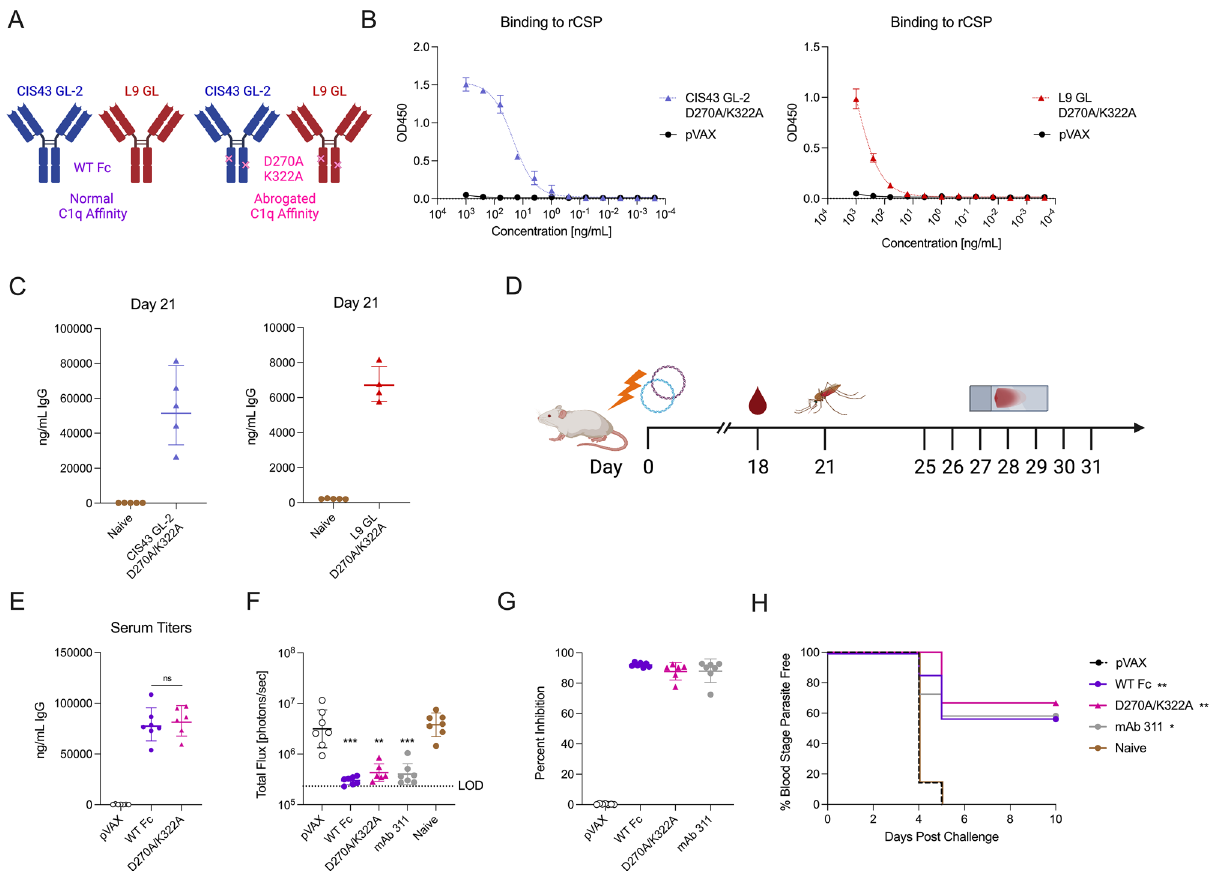
Figure 3. Complement-binding knockout modifications do not impact protection in mosquito bite challenge model. ( A ) Graphical representation of complement modifications of CIS43 GL-2 and L9 GL. ( B ) Binding ELISA of pooled supernatants of CIS43 GL-2 constructs (left) and L9 GL constructs (right) harvested from Expi293F transfection to rCSP (mean ± SD). ( C ) In vivo expression of CIS43 GL-2 D270A/K322A (left) and L9 GL D270A/K322A (right) in BALB/c mice at the peak expression timepoint Day 21. Mice were immunized with 100 µg CIS43 intramuscularly in the tibialis anterior with CD4+/CD8+ T cell depletion (n = 5 mice/group; geometric mean ± geometric SD). ( D ) Experimental layout of challenge. Mice were immunized with CIS43 GL-2 (50 µg) and L9 GL (100 µg) (abbreviated “WT Fc”) or CIS43 GL-2 D270A/K322A (50 µg) and L9 GL D270A/ K322A (100 µg) (abbreviated “D270A/K322A”)and challenged 21 days post administration with mosquitos carrying PbPfLuc parasites. ( E ) Serum titers of DMAb 18 days post administration. ( F ) Total flux quantified by IVIS (geometric mean ± geometric SD) ( G ) Percent inhibition of liver infection relative to infection of naive control infected mice (geometric mean ± geometric SD). ( H ) Percent of blood stage parasite free mice, determined through blood smears (n = 6–7 mice/group). Statistical analyses were done using a two-tailed Mann–Whitney test between treatment groups ( E ), with comparisons relative to naïve infected ( F , H ) or one- way ANOVA adjusted for multiple comparisons between all treatment groups ( G ). **p < 0.01, ***p <